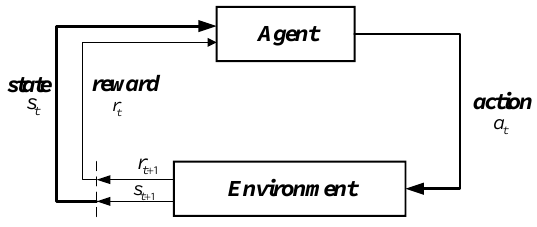
Figure 1. The principle of reinforcement learning.